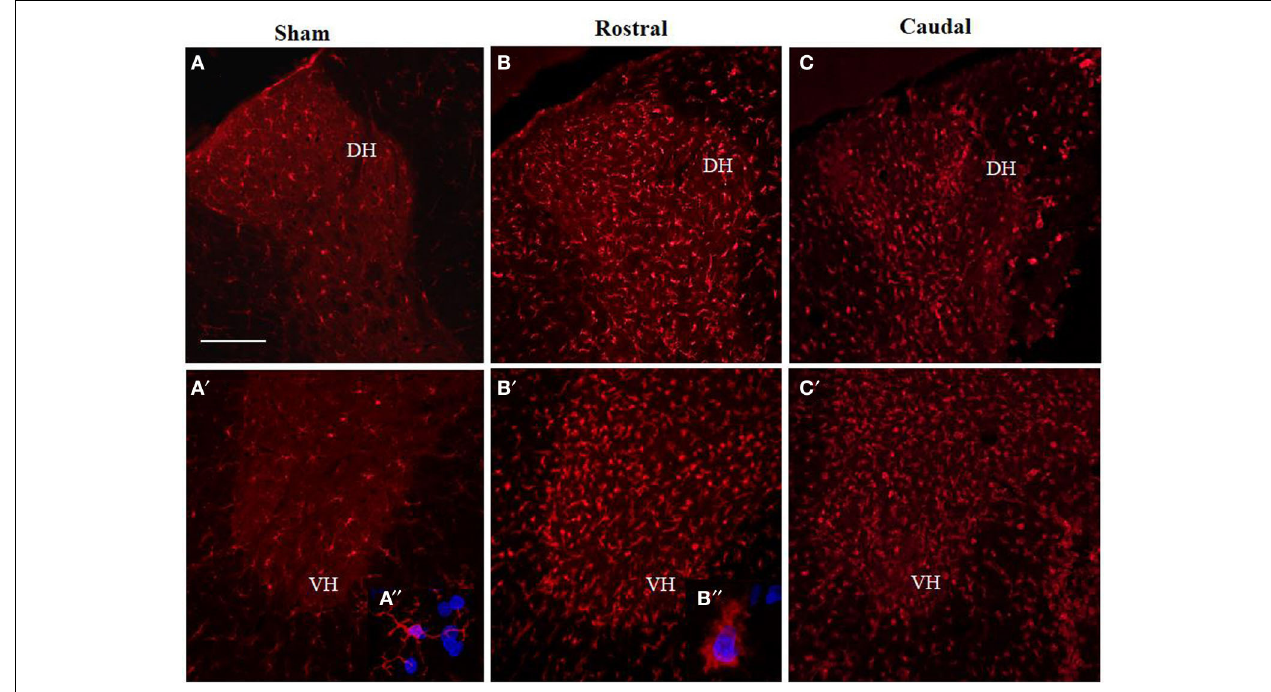
FIGURE 5 | Comparison of Iba1 immunoreactivity (IR) in coronal thoracic spinal cord sections of sham rats (A,A’) and rats 3 days after injury in rostral (B,B’) and caudal segments (C,C’) in the dorsal (upper) and ventral horn (lower panel). Note, significantly